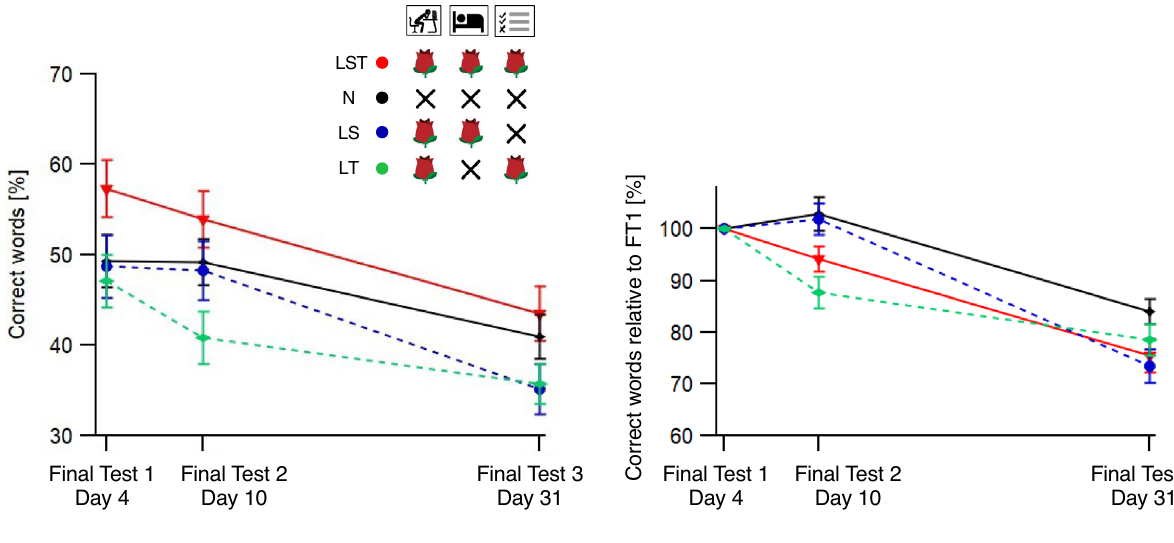
Figure 5. Left: Mean percentage of correct words ± SEMs for all conditions and Final Tests. Right: Mean percentage of correct words relative to Final Test 1 ± SEMs for all conditions and Final Tests. On the x-axis, the different tests are displayed (Final Tests F1 on Day 4, F2 on Day 10, F3 on Day 31). The LST Condition is displayed in red, the N Condition in black, the LS Condition in dashed blue and LT in dashed green.